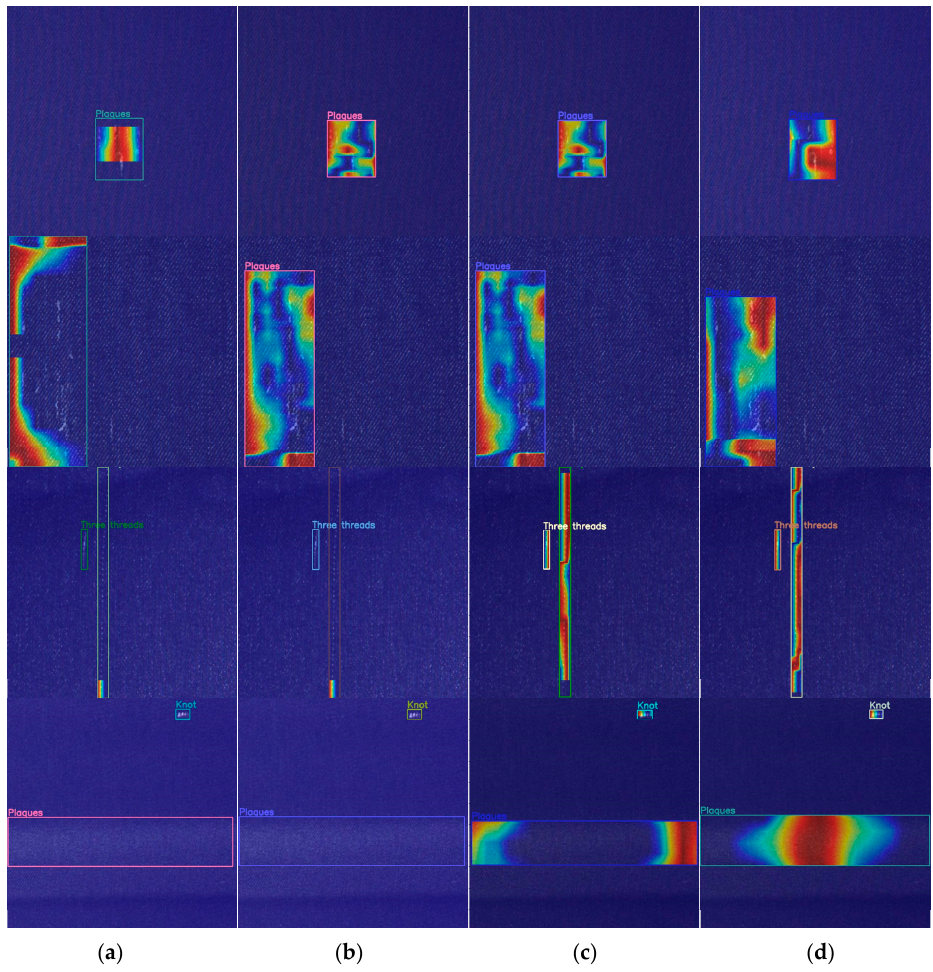
Figure 12. Heatmaps of different networks in ablation experiments: ( a ) CAM heat map of YOLO-LB; ( b ) CAM heat map of YOLO-SL; ( c ) CAM heat map of YOLO-SB; ( d ) CAM heat map of YOLO-TLB.